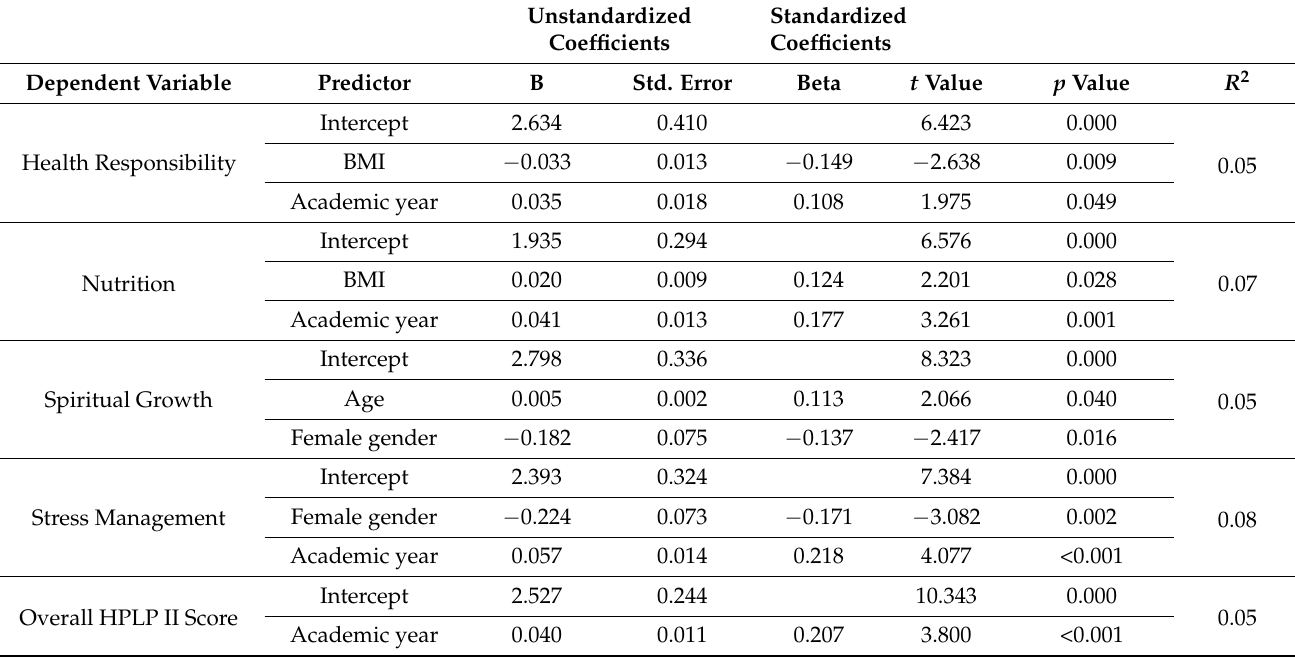
Table 4. Multiple regression analysis of predictors for the overall HPLP II score and certain HPLP II subcategories.